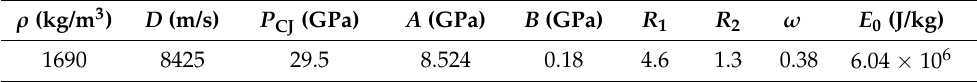
Table 3. 8701 explosive parameters.